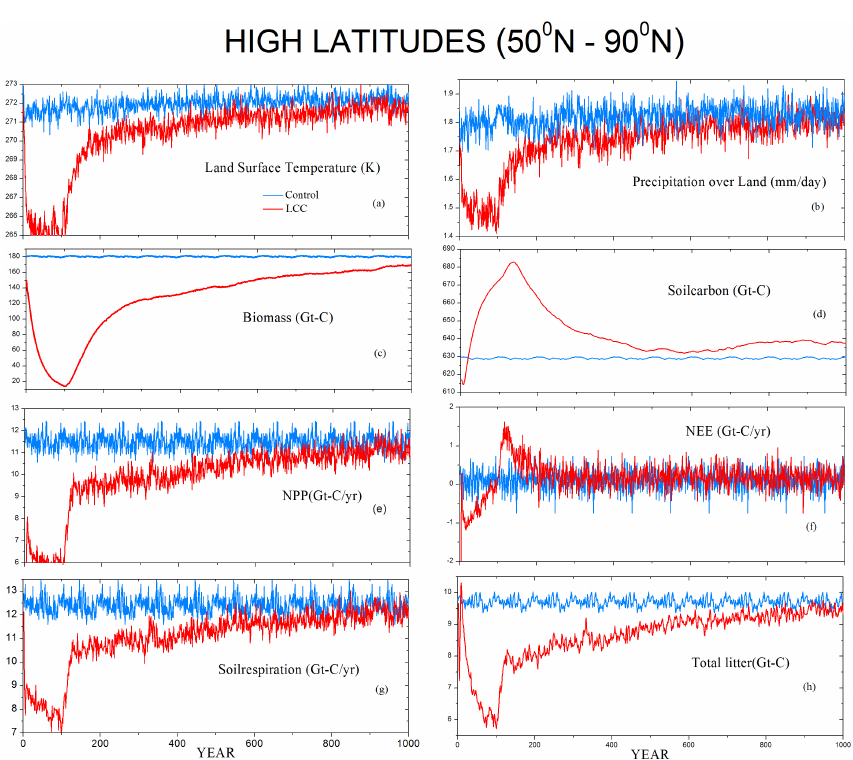
Fig. 3. Evolution of annual mean (a) land surface temperature, (b) precipitation over land, (c) biomass, (d) soil carbon, (e) net primary productivity (NPP), (f) net ecosystem exchange (NEE), (g) soil respiration (includes heterotrophic respiration and disturbances), and (h) total litter for the 1000-yr control and LCC simulations in the northern hemisphere high latitudes(50 ◦ N–90 ◦